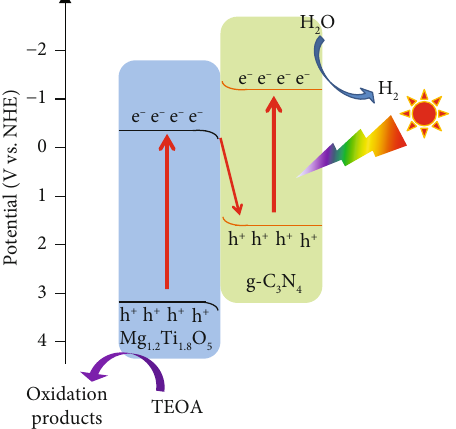
Figure 9: A possible photocatalytic mechanism for H based on MT/CN heterostructure.